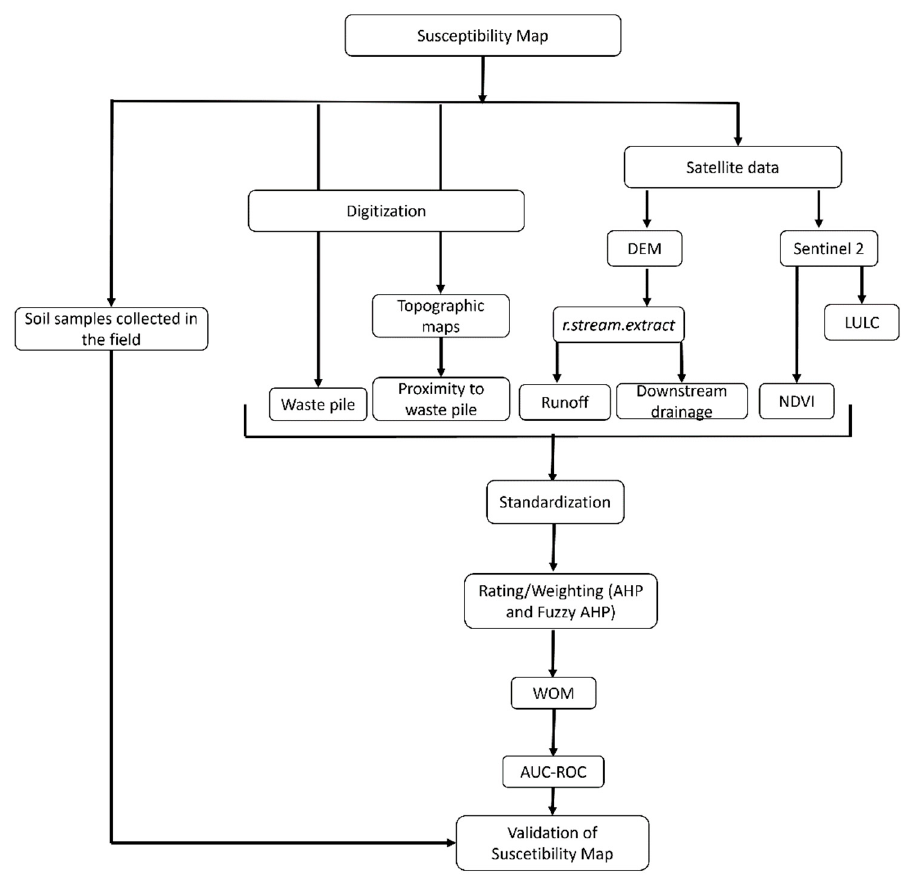
Figure 2. Flowchart presenting the data and methodology used in this study.